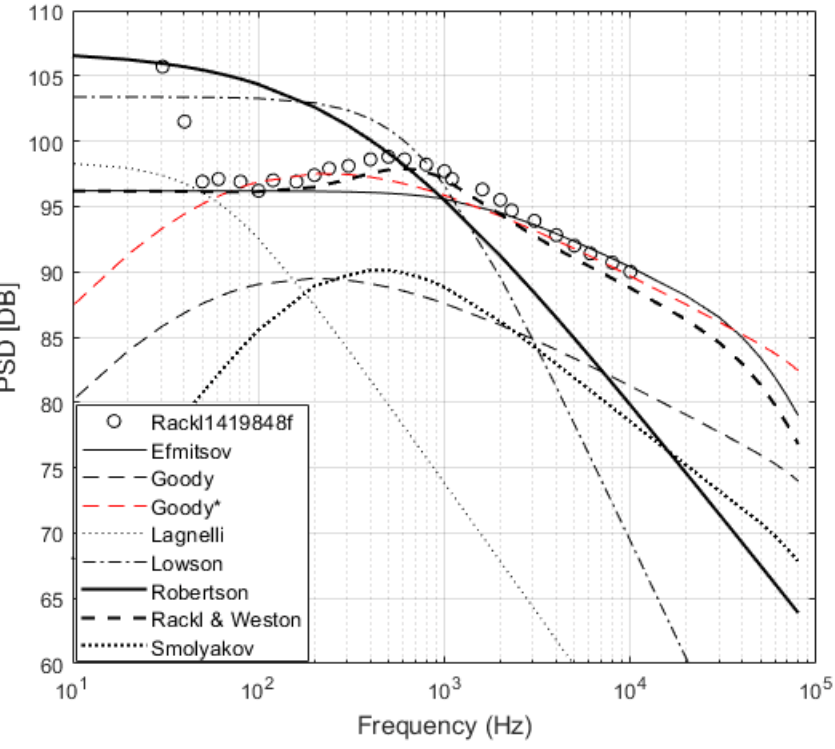
Figure 4. Rackl419848f from Tu144 window bank 4 compared to models, MSE for each